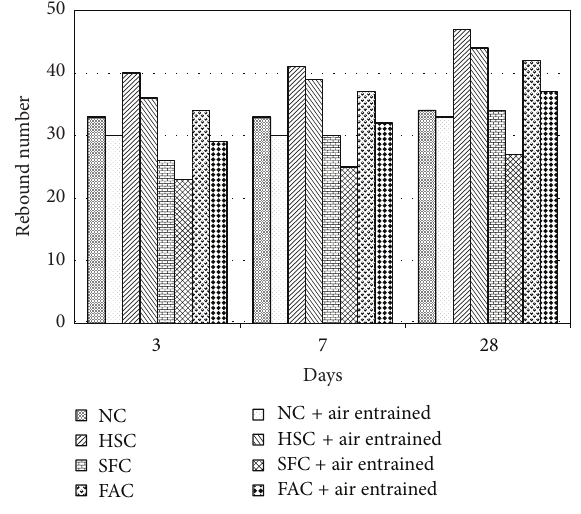
Figure 4: Schmidt hammer test results.